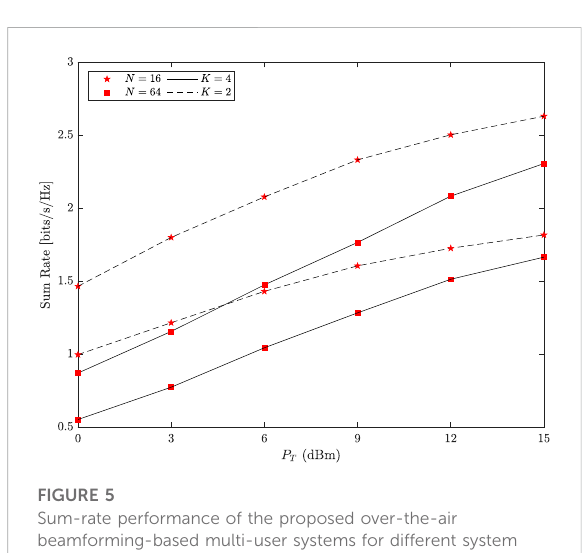
FIGURE 5 Sum-rate performance of the proposed over-the-air beamforming-based multi-user systems for different system con fi